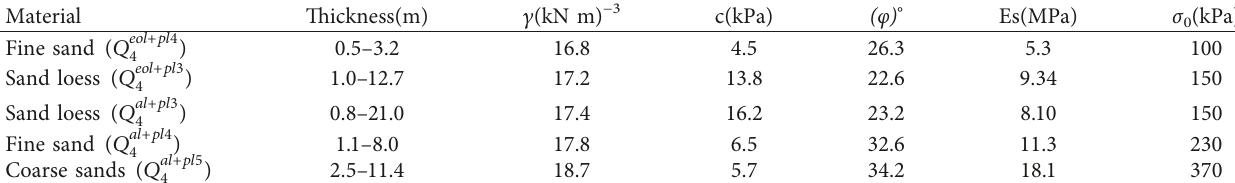
Table 1: Soil parameter of the Beitan station.